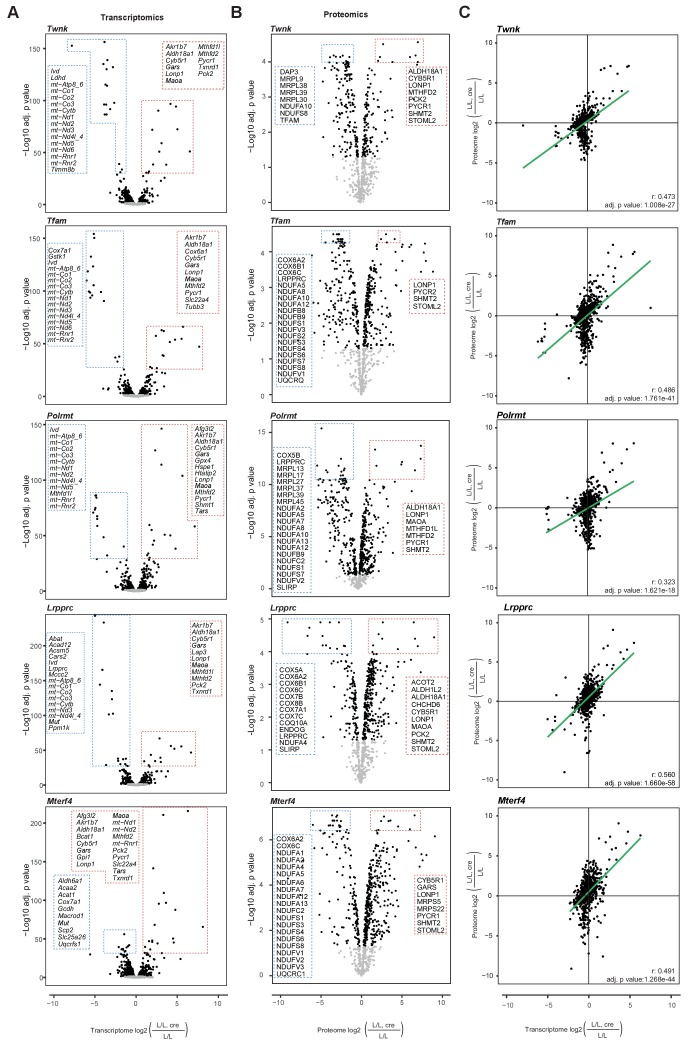
Most of the identified transcripts of nuclear genes encoding mitochondrial proteins are decreased, whereas most of the quantified mitochondrial proteins were increased in abundance.(A) Volcano plots of transcripts of genes encoding mitochondrial proteins for each knockout mouse strain. (B) Volcano plots of mitoproteomes for each knockout mouse strain. Black: p<0.05, grey: p>0.05. Top 1% of significantly changed mitochondrial transcripts and top 5% of significantly changed mitochondrial proteins are shown and listed in the dotted line boxes; red: increased, blue: decreased; p values were adjusted using Benjamini-Hochberg method. (C) Scatterplots showing the correlation between the mitochondrial transcriptomics and proteomics data for each knockout mouse strain (L/L, cre compared to L/L). Each point corresponds to one quantified gene. Correlation coefficient and p values were calculated with Pearson correlation test.